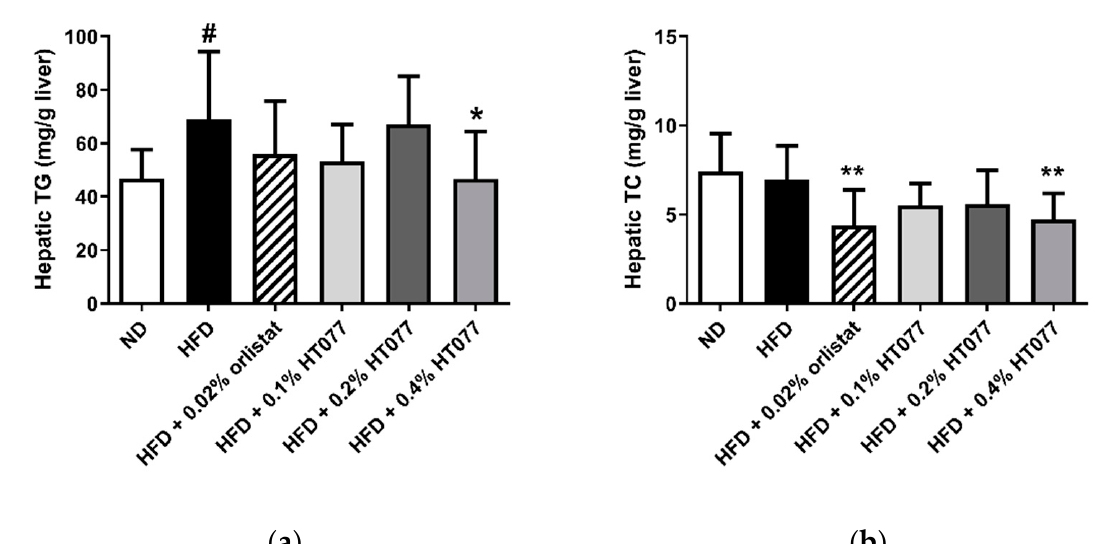
Figure 5. Effects of an extract mixture of Prunus persica and Nelumbo nucifera (HT077) on hepatic triglyceride ( a ) and total cholesterol ( b ) contents in C57BL/6 mice fed a high-fat diet (HFD). Mice received either a normal diet (ND), HFD, HFD containing 0.02% orlistat, or HFD containing 0.1, 0.2, or 0.4 HT077 for 12 weeks. All values are presented as the mean ± SD ( n = 8 for ND, 16 for HFD, and 12 for the other groups). # p < 0.05 vs. ND group. * p < 0.05 and ** p < 0.01 vs. HFD control group. TC, total cholesterol; TG, triglyceride.